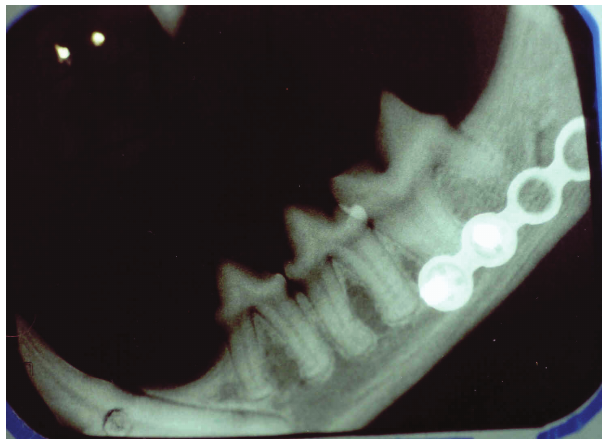
FIGURE 6 - Intraoral radiograph taken 20 weeks after surgery shows incorporation of the graft into the segmental defect. Cat 14 of Group 1.